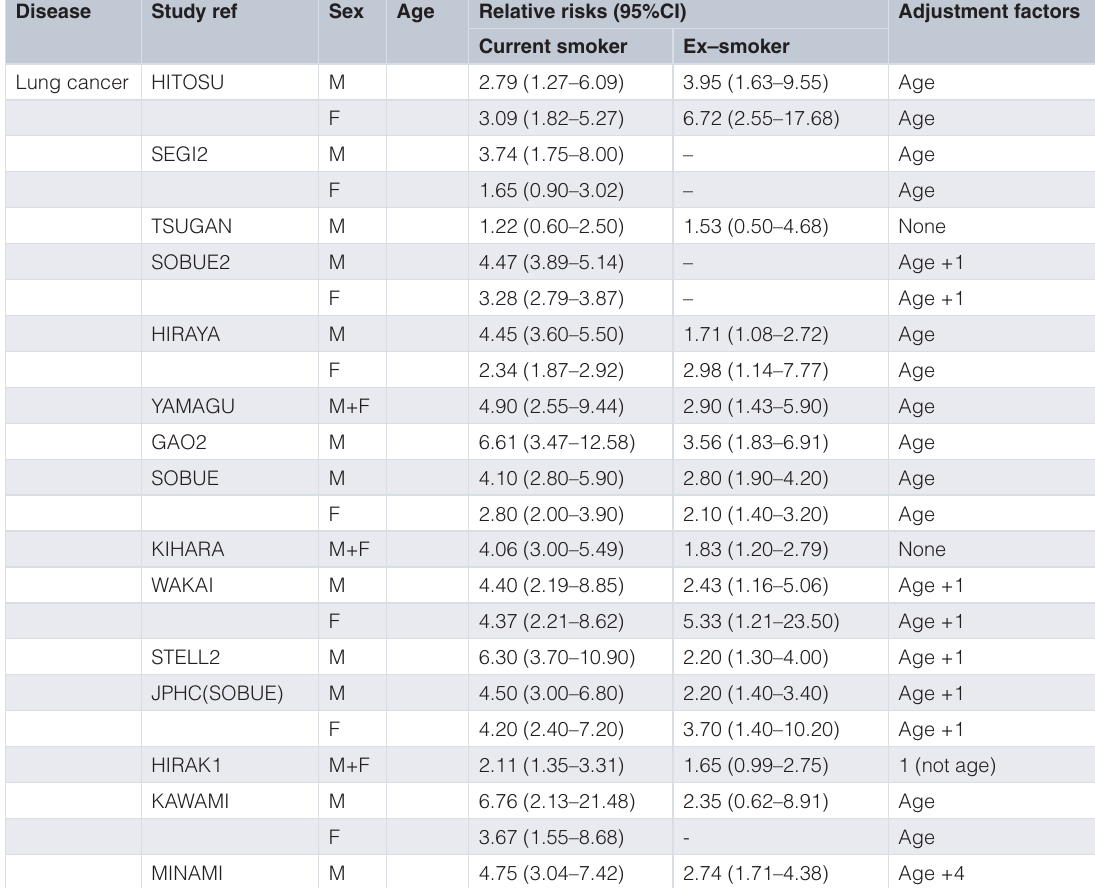
Table 2. Relative risks for current and for ex-smokers (vs never smokers).